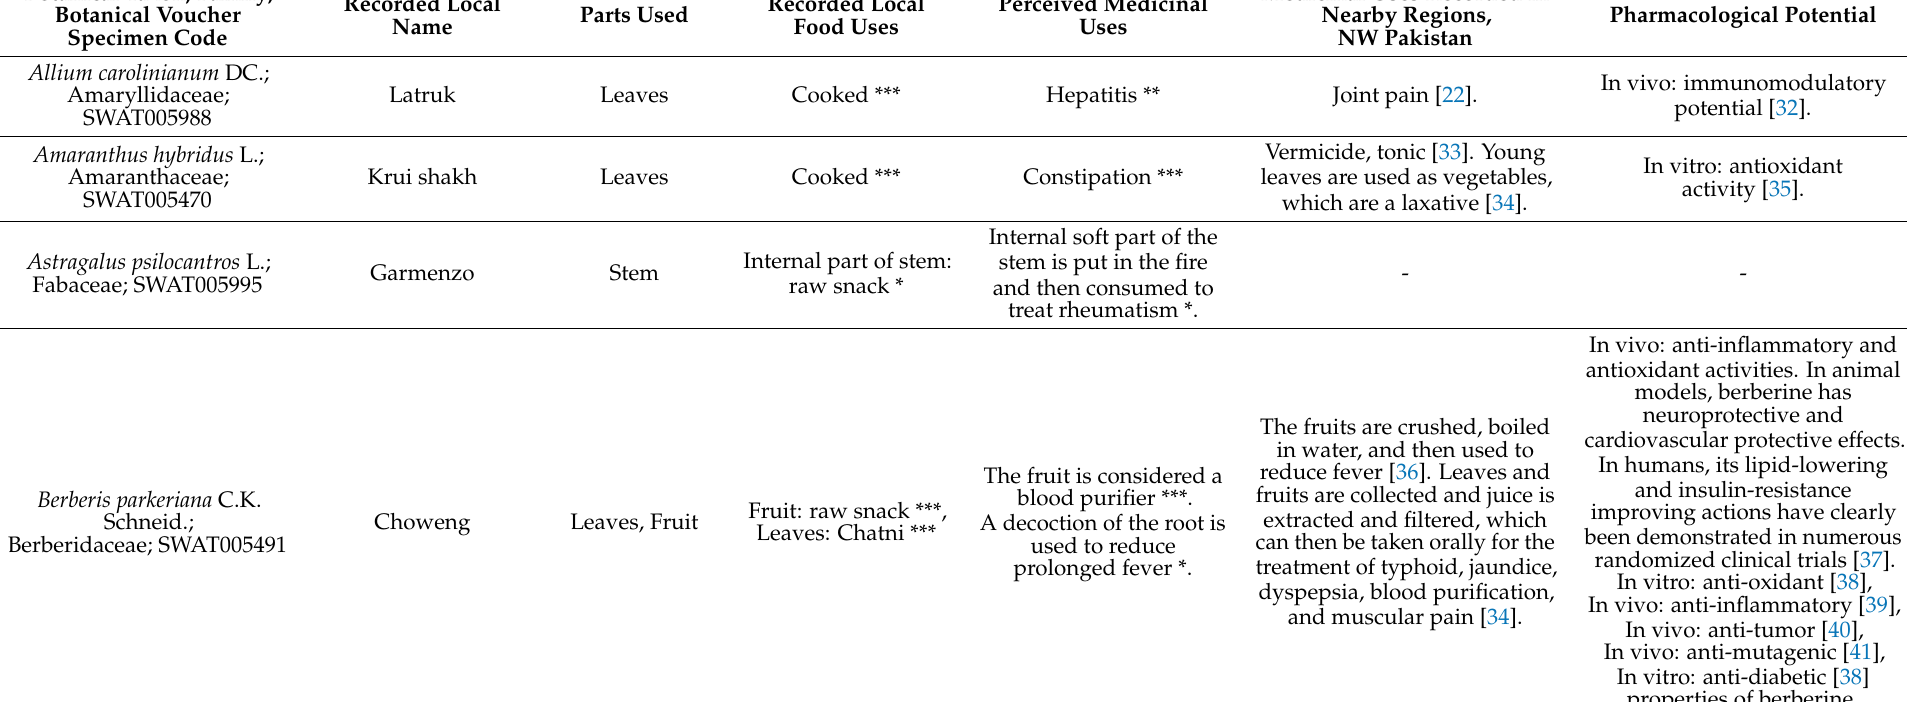
Table 1. WFPs used as food–medicines, along with their pharmacological properties, reported among local communities living in North Pakistan. Botanical Taxon; Family; Botanical